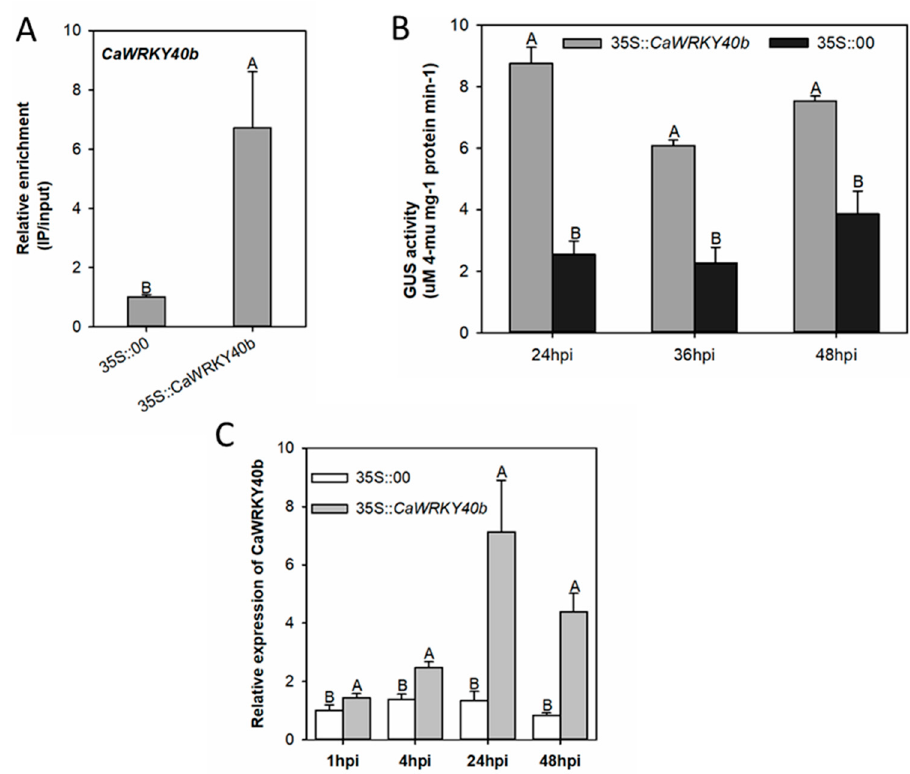
Figure 7. The transcriptional self-regulation of CaWRKY40b. ( A ) The binding of CaWRKY40b to the promoter of CaWRKY40b by ChIP and real-time PCR. GV3101 cells containing 35S::CaWRKY40b -HA infiltrated into pepper leaves, with GV3101 cells containing 35S::00 as mock treatment. The CaWRKY40b -HA overexpressing leaves were harvested at 48 hpi for chromatin preparation. Chromatin was isolated from infiltrated pepper leaves crosslinked with 1% formaldehyde, sheared, and immune-precipitated with an anti-HA antibody. Relative enrichment levels of CaWRKY40b in the promoter of CaWRKY40b were set to 1 after normalization by input. ( B ) pCaWRKY40b -driven GUS expression was triggered by transient overexpression of CaWRKY40b after infiltration of Agrobacterium into the leaves. The pepper leaves were also co-infiltrated with GV3101 possessing pCaWRKY40b ::GUS or 35S::CaWRKY40b . ( C ) The transcript level of CaWRKY40b against transient overexpression of CaWRKY40b in pepper leaves by real time RT-PCR: for transcript level of CaWRKY40b in CaWRKY40b overexpressing leaves, the primer pair based on the 3 ′ UTR was used. Data are the means ± SD of four independent biological replicates. Capital and lowercase letters above the bars indicate significantly different means at p < 0.01 and p < 0.05, respectively, as analyzed by Fisher’s protected LSD test.